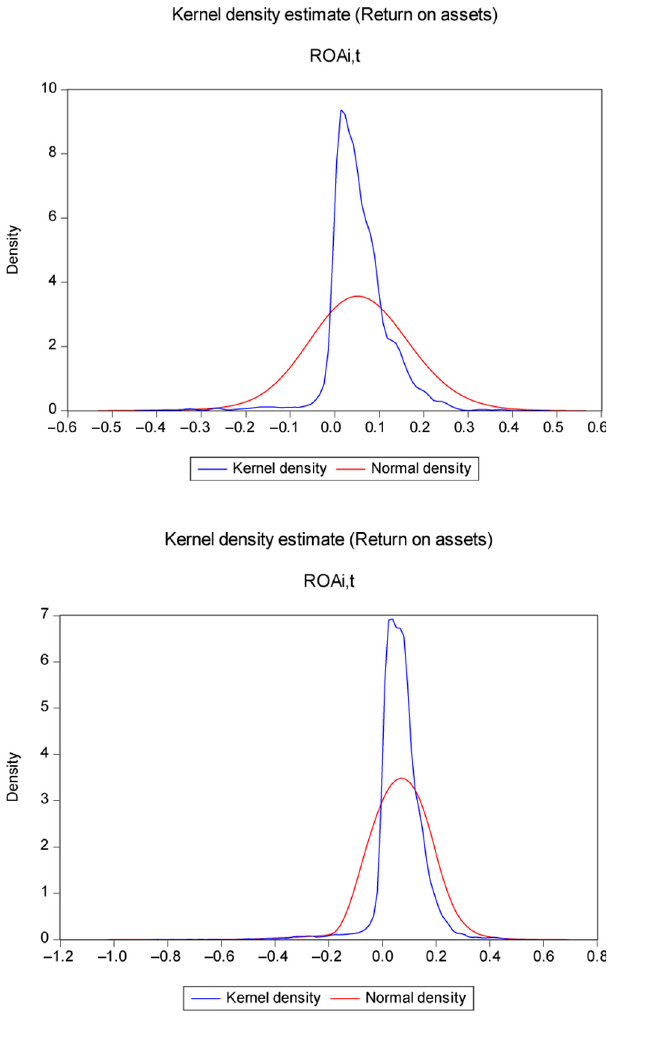
Figure 10. Non-normality